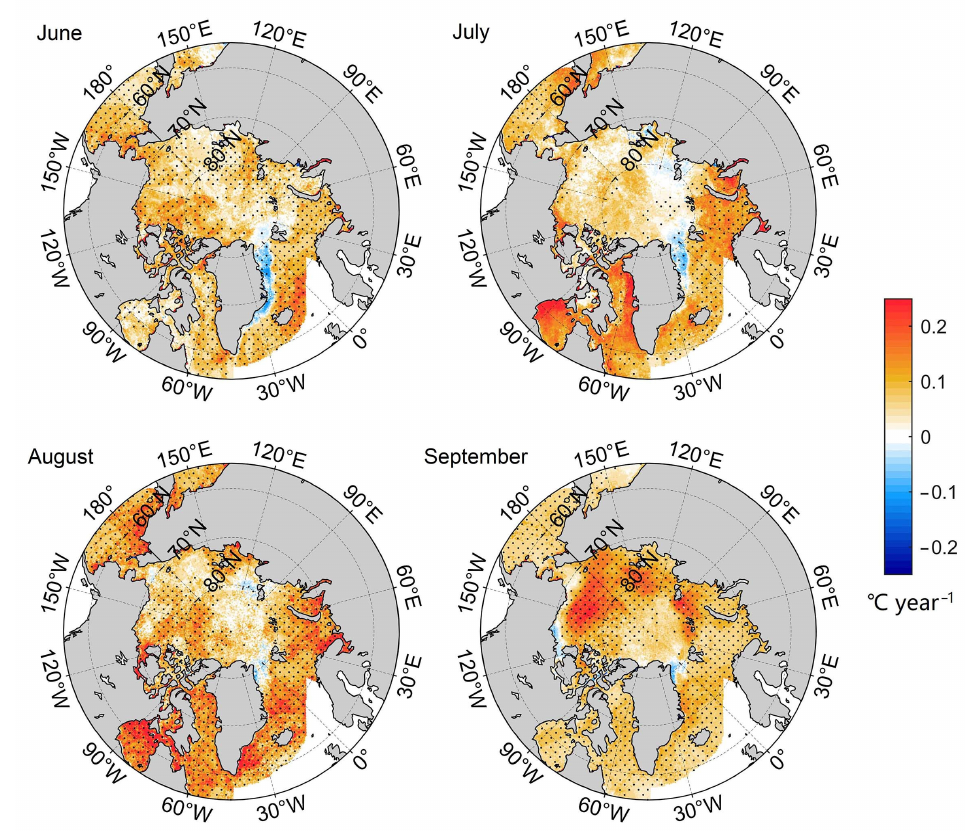
Figure 7. Trend in monthly Arctic APP-x skin temperature for 1982–2018. Black dots indicate the trends that are significantly above the 95% significance